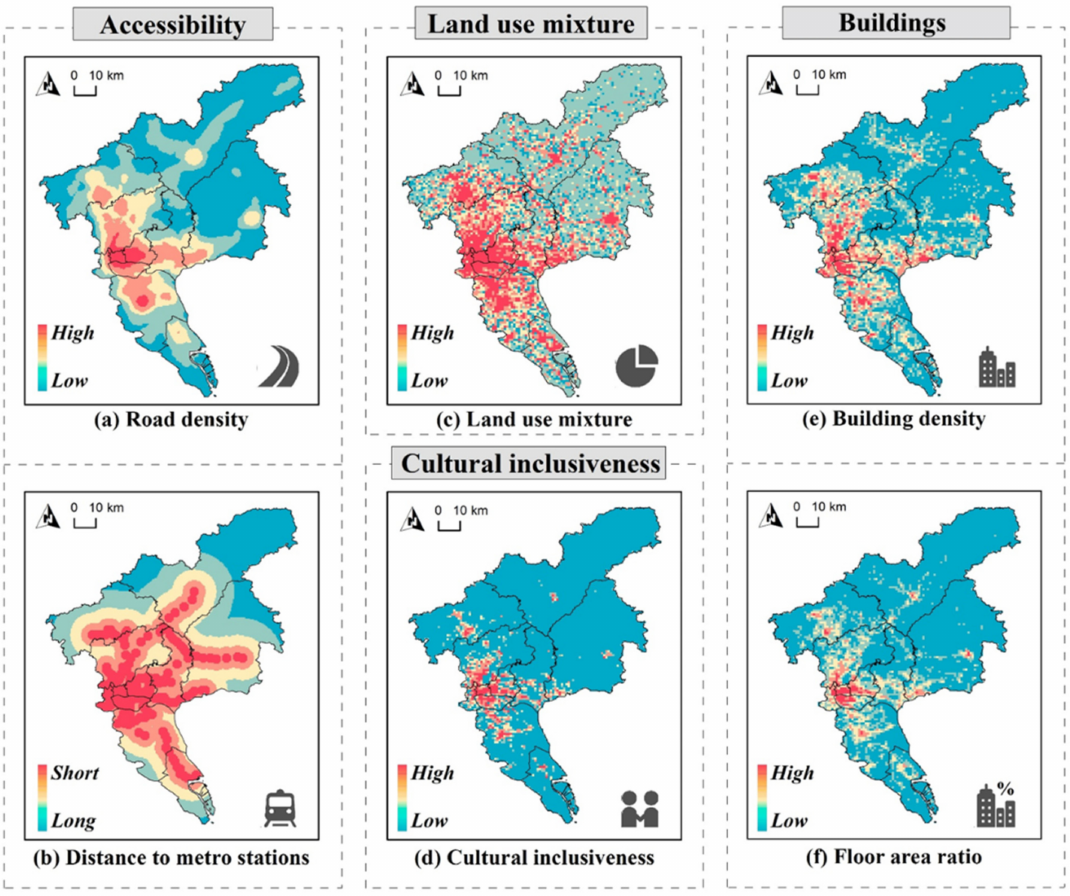
Figure 5. Spatial distribution of selected factors: ( a ) road density, ( b ) distance to metro stations, ( c ) land use mixture, ( d ) cultural inclusiveness, ( e ) building density, ( f ) floor area